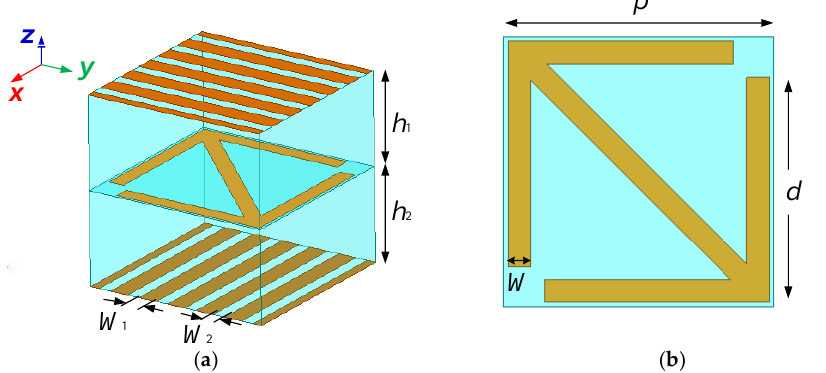
Figure 1. Structure diagram of metasurface element: ( a ) the element presented in this paper; ( b ) arrow-shaped metal patch.